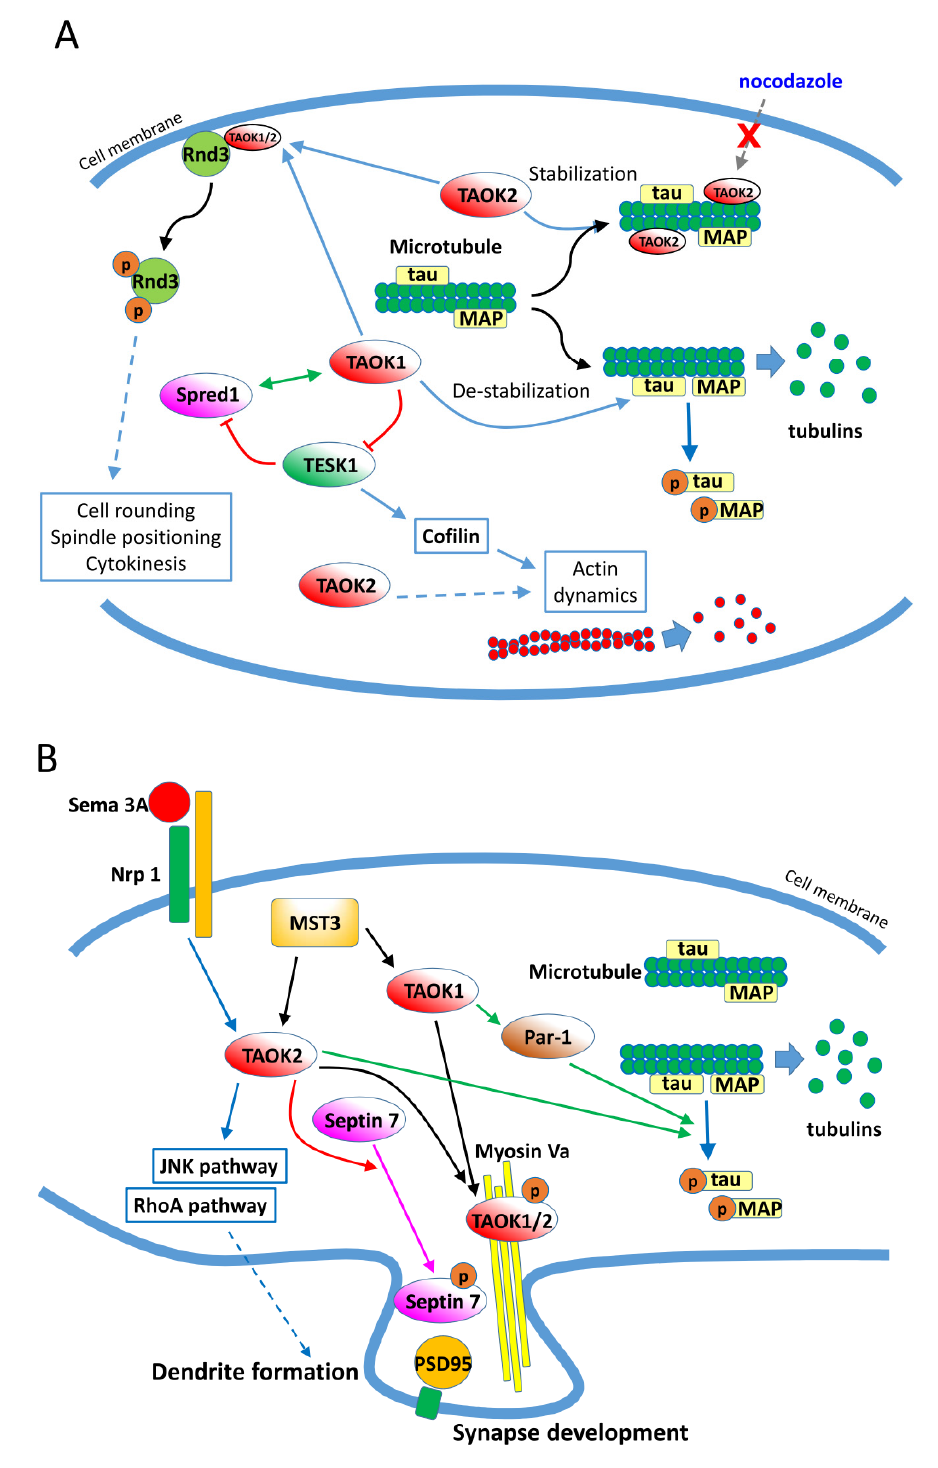
Figure 3. Regulation of cytoskeleton components by TAOKs. ( A ) Regulation of microtubules and actin filaments by TAOK1 and TAOK2 in normal cells. ( B ) Signaling pathways modulated by TAOK1 and TAOK2 in neurons during development and dendrite/synapse formation. MAP: microtubule-binding proteins.